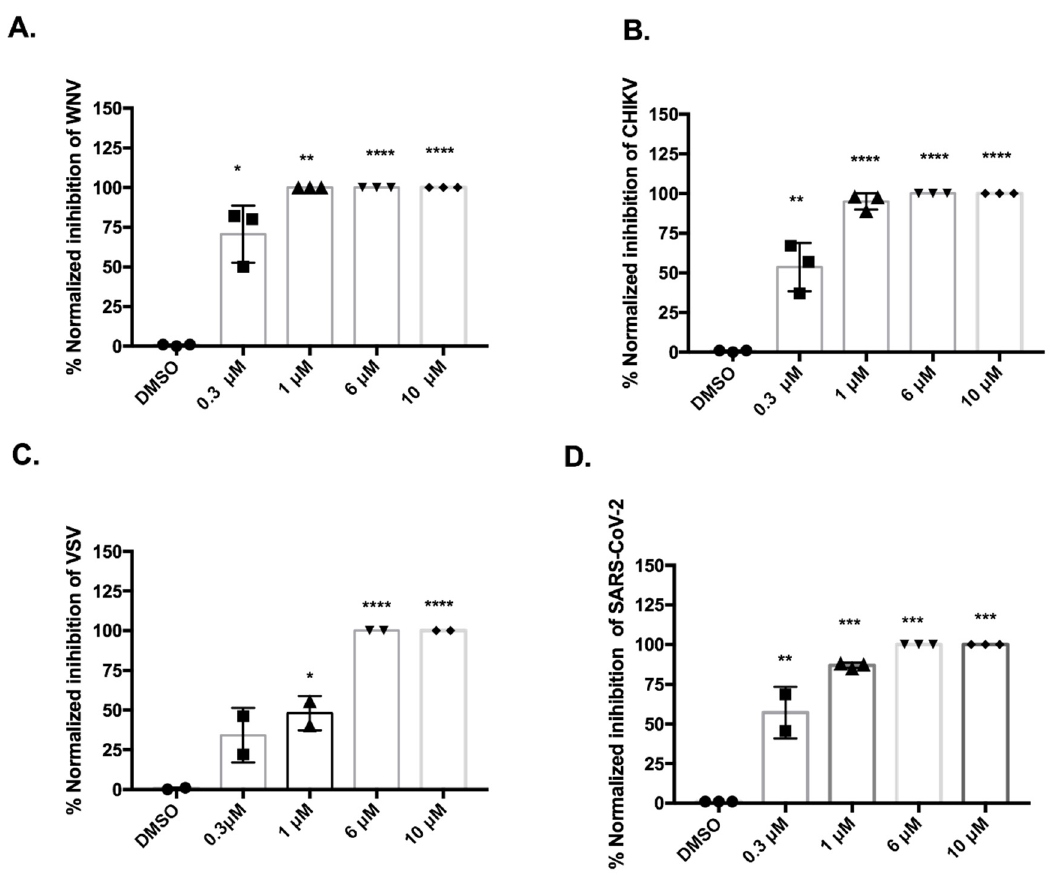
Figure 4. Virucidal effect of 17Y against enveloped RNA viruses. Virus inoculum was pre-incubated for one hour with the indicated concentrations of 17Y, or 1% DMSO as vehicle. The inoculum was diluted 1/10 before infection of Vero E6 cells. Plaques were counted 72 h post infection. Inhibition (%) for ( A ) WNV, ( B ) CHIKV, ( C ) VSV, ( D ) SARS-CoV-2 was calculated from the normalised ratio of 17Y-treated over vehicle-treated samples. Columns and bars represent the average and STDV from replicates of two/three independent experiments (the result of each measure is reported using circle, square or triangle symbols). Significant p -values are indicated as follows: **** p < 0.0001 highly significant; *** p < 0.001, ** p < 0.01, * p < 0.05 weakly significant, measured with a paired two-tailed t -test.